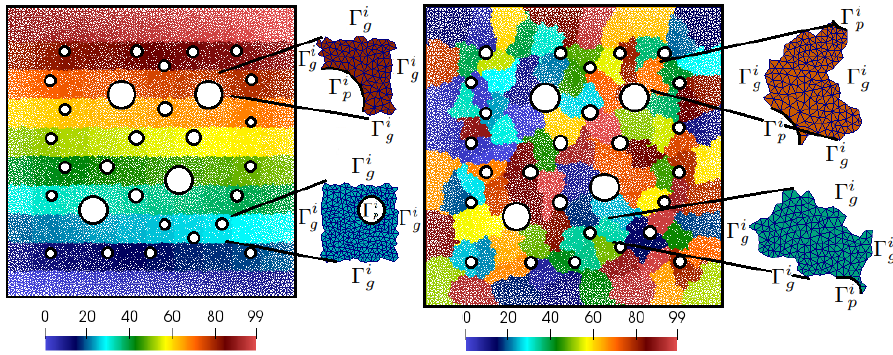
Figure 14. Coarse grids and local domains. ( Left ): quasi-structured grid. ( Right ): unstructured